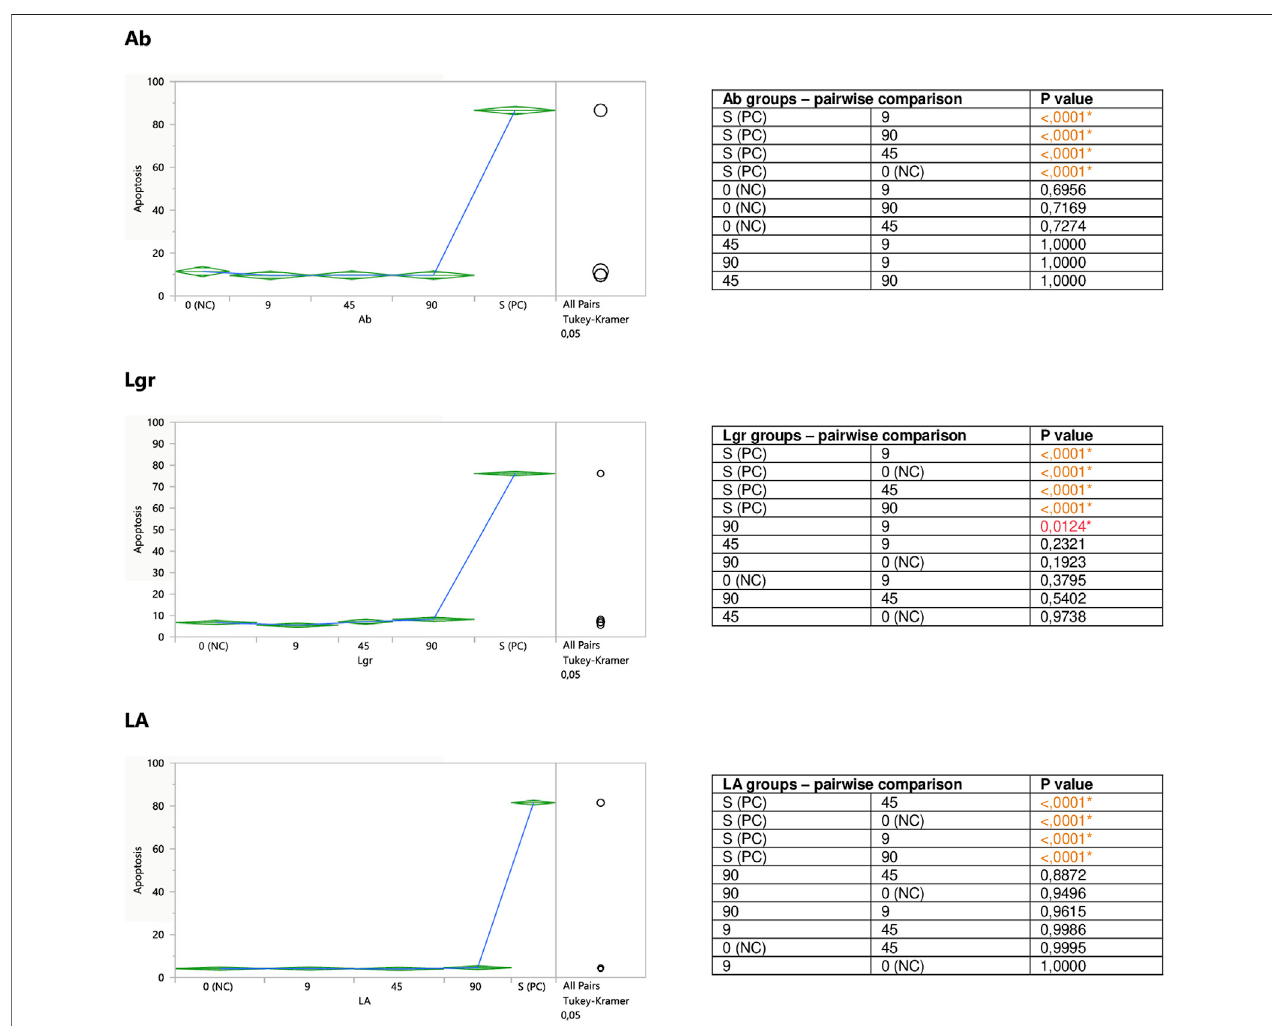
FIGURE 6 | Direct effect of Ab, Lgr, and LA on apoptosis of Jurkat cells. 0 (NC) = negative control (untreated Jurkat cells); S (PC) = positive control (Jurkat cells treated with staurosporine); 9, 45, 90 = Jurkat cells incubated with a given (poly)phenol at the concentration of 9, 45, or 90 µM. Apoptosis = percent of apoptotic cells. MeansdiamondsillustrateANOVAanalysis(upperandbottompointsareat95%con fi dencepointsofeachgroup).Thecirclesontherightexpresssigni fi cantdifferences between group means (if they do not overlap), or the lack of signi fi cant differences (if they